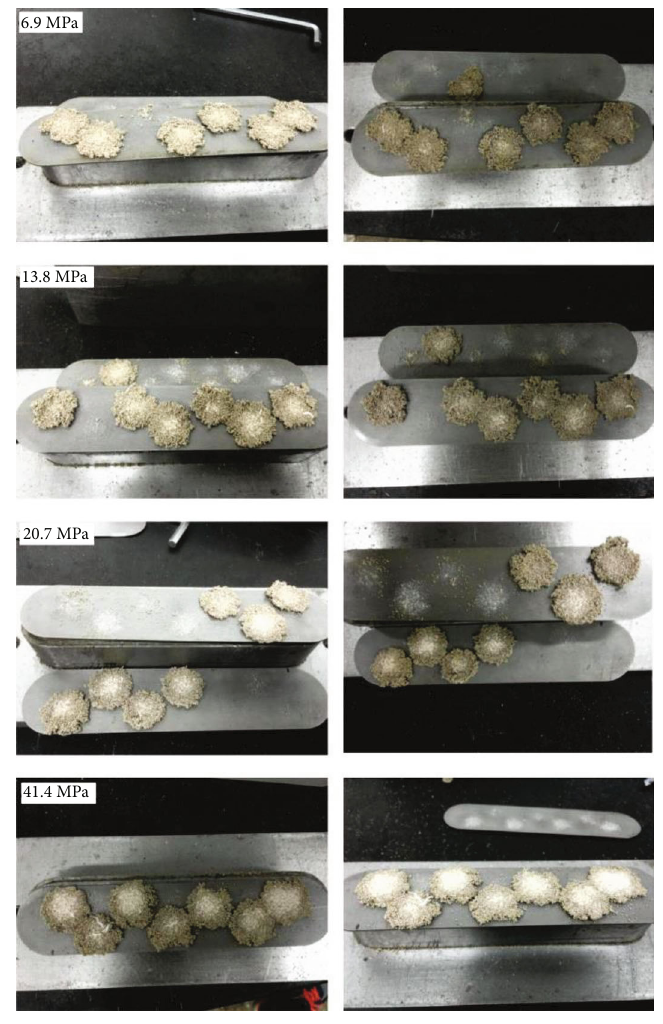
Figure 6: Deformation shape of proppant column.